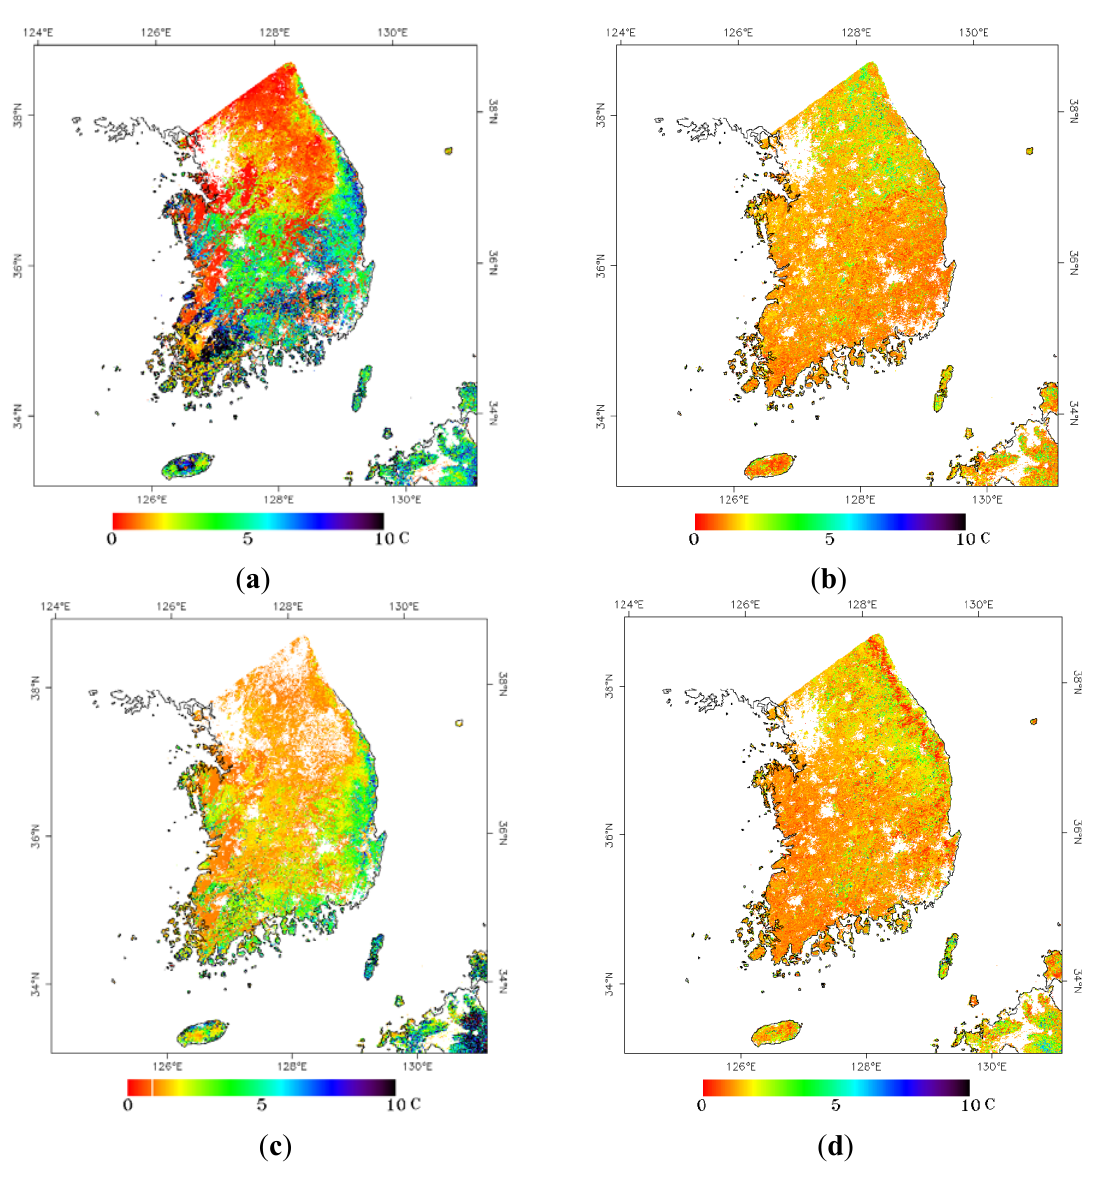
Figure 12. Spatial distribution of WUE in South Korea. ( a ) 17–24 January 2007. ( b )